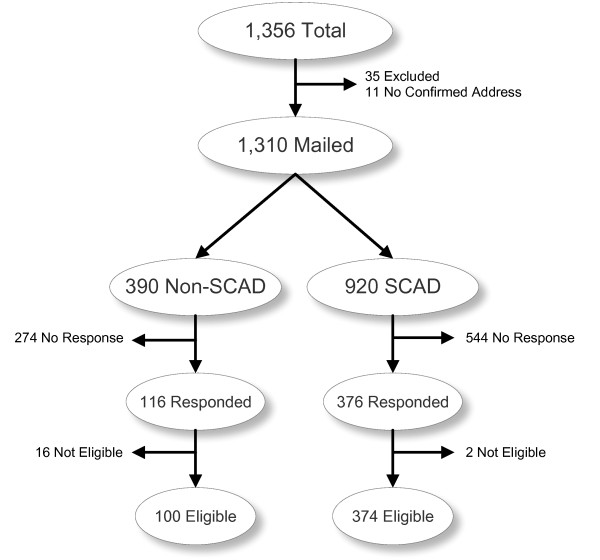
Survey strategy.